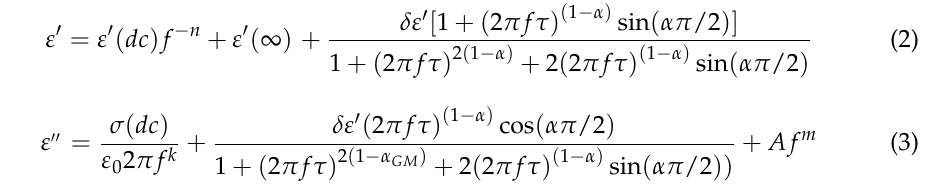
dots (Mix 1 to Mix